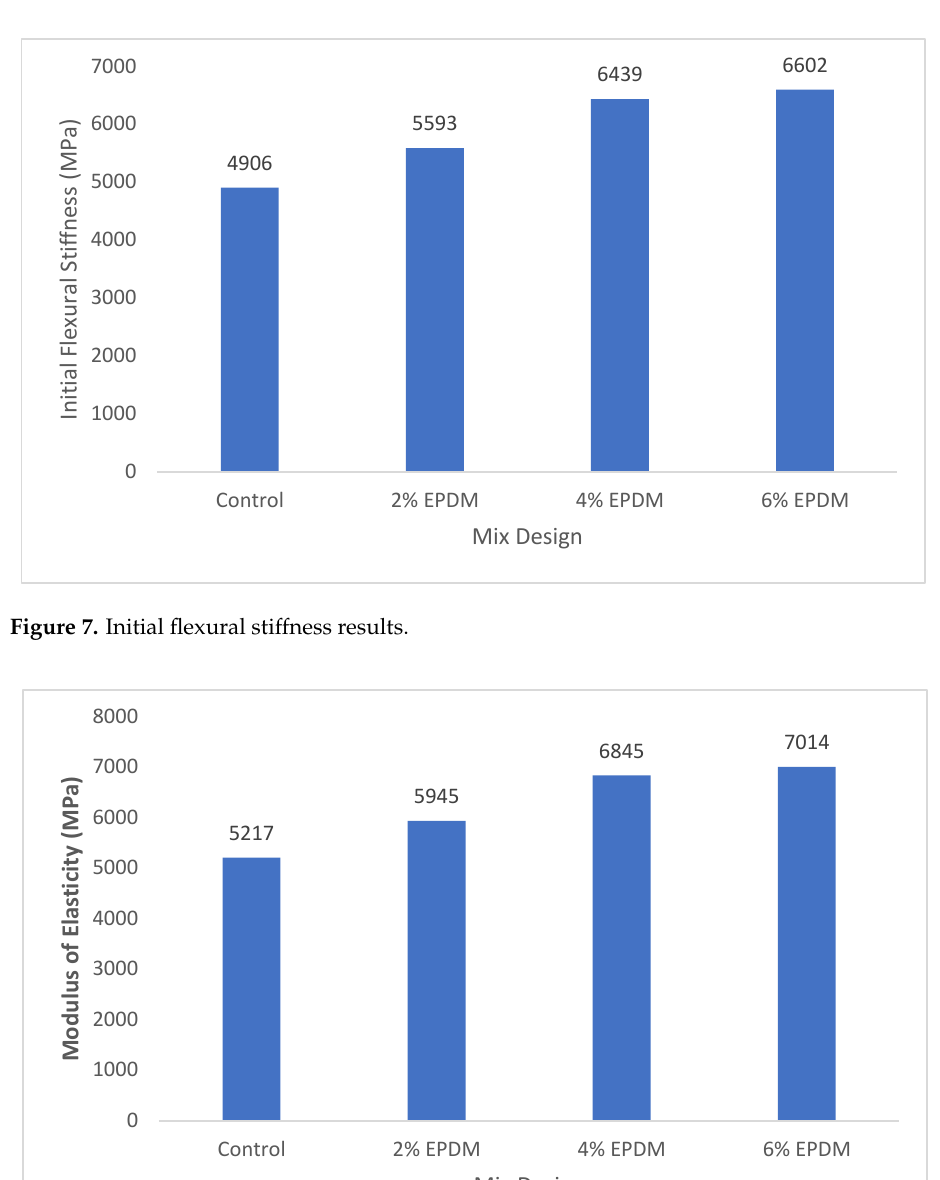
10 of 14 Figure 6. Wheel-tracking test results.